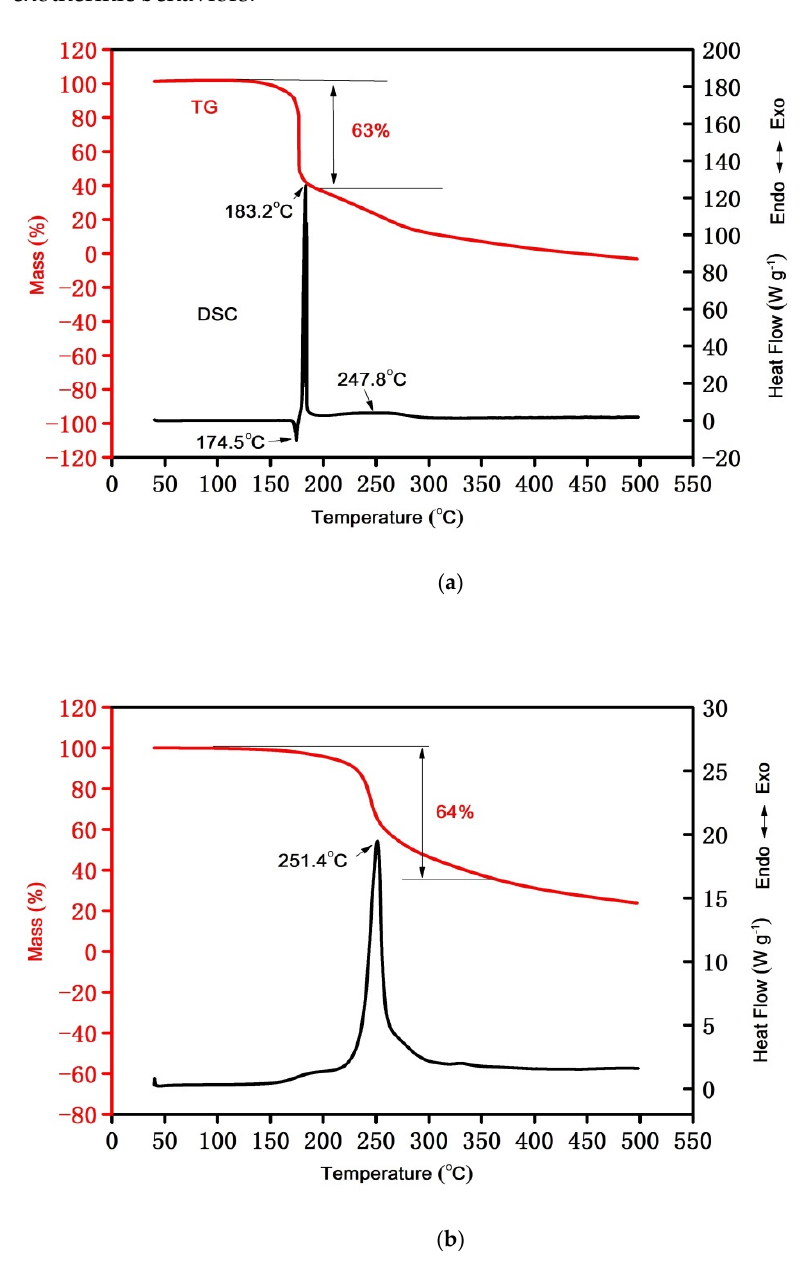
Figure 2. DSC-TG curves of LLM-116 ( a ) and LLM-226 ( b ). With the raise of the heating rates, the thermal decomposition peaks of both LLM-116 and LLM-226 moved to high temperatures. (Figure 3a,b) To further analyse the thermal decomposition behaviors of LLM-116 and LLM-226, their TG-DTG curves were also studied. (Figure 3c,d) Both of their TG-DTG curves showed a single DTG curve peak. The